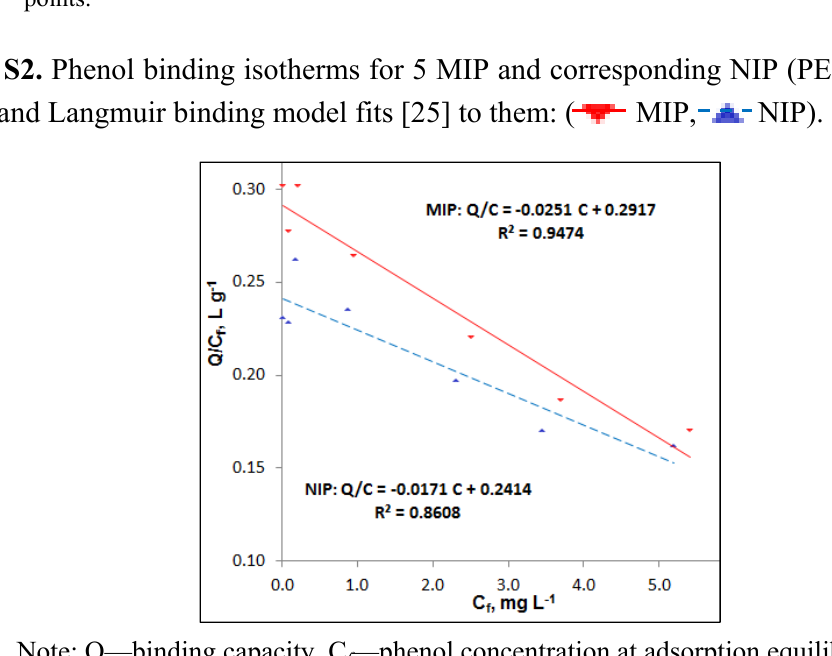
Figure S2. Phenol binding isotherms for 5 MIP and corresponding NIP (PETA) in Q/C